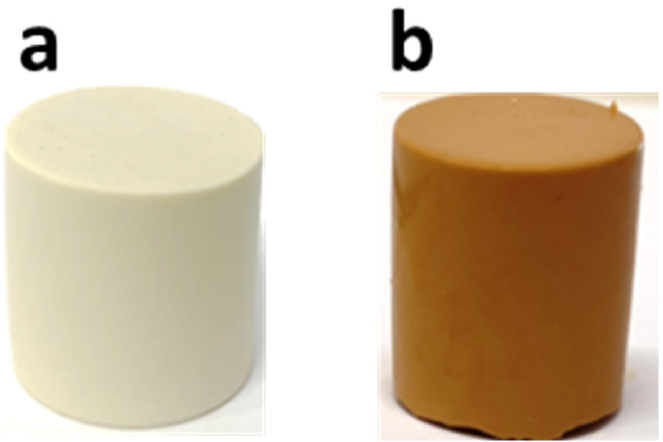
Figure 2. Images of the geopolymer specimen ( a ) without, GP, and ( b ) with acridine orange, GPAO. Ionic conductivity and pH measurements revealed that after 56 days of ageing time, the pH values were 12 (Figure S1), and the GPAO sample had an ionic conductivity of 500 mS/m (Figure S2B), which was higher than the one without the dye (300 mS/m, Figure S2A). Both samples were completely hardened after 56 days of ageing time; indeed, they did not break after the integrity test (Figure S3 and Table S1) and had a weight loss lower than 1.5% after 56 days of ageing (Figure S4). GPAO released a small amount of the dye into the eluate water after both the integrity and weight loss